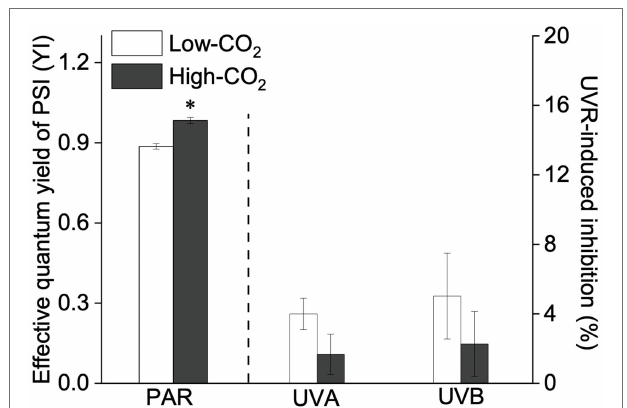
FIGURE 4 | Values (a.u., left pair of bars) and UVR-induced inhibition (%, right two pairs of bars) of the effective quantum yield of PSII (YI) of P. yezoensis growing for 9 days at low (~400 μ atm, open bars) and high (~1000 μ atm, closed bars) CO 2 conditions. Data are means ± SD ( n = 3). The symbols “ * ” indicates a significant ( p < 0.05, t -tests) difference between the treatments in each